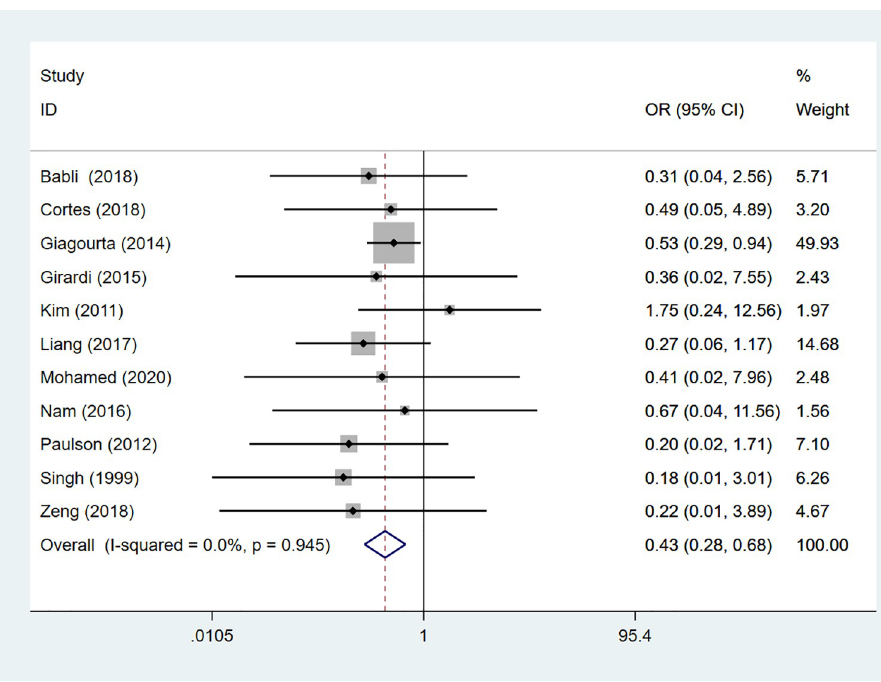
Fig 3. The forest plot of distant metastasis between HT group and non-HT